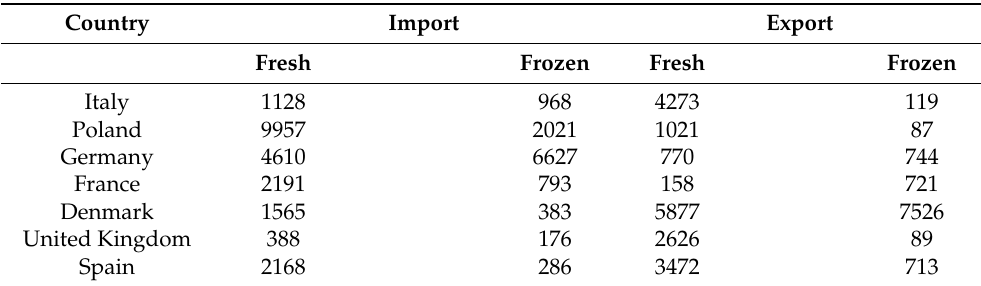
Table 7. Main exporting and importing countries of rainbow trout in the European Union ( × 1000 t).